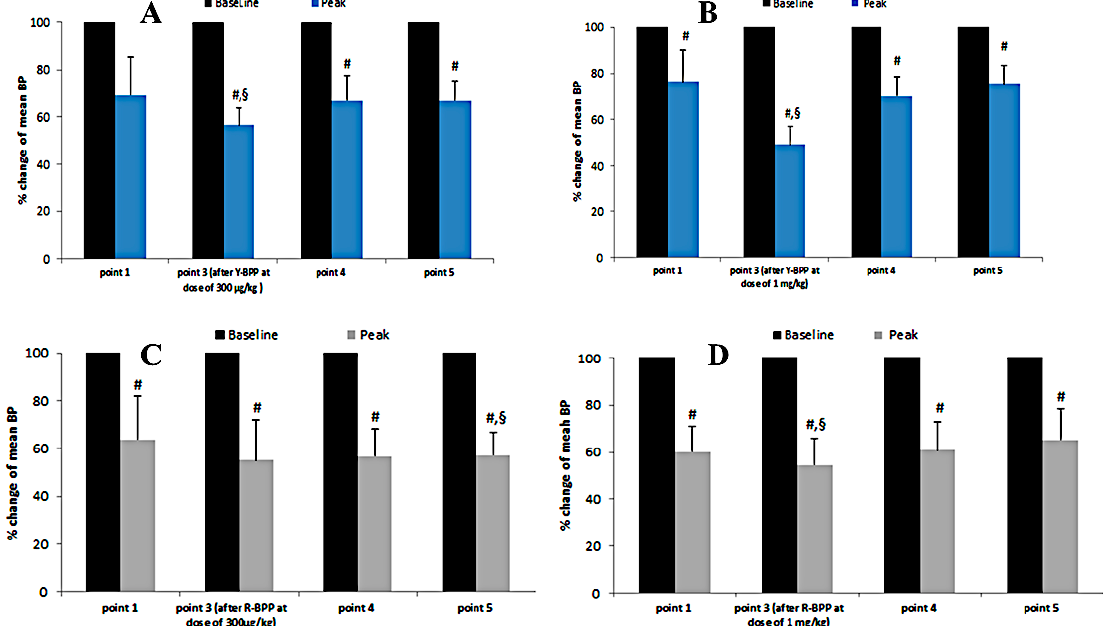
Figure 9. Percent changes from baseline for mean BPs after injections of bradykinin at a dose of 7 µg/kg in response to bradykinin-potentiating effects of A. feae peptides Y-BPP ( A , B ) and R-BPP ( C , D ) at two doses. # p ≤ 0.05 vs. baseline according to the T-Test for comparing the data of one group before and after treatment, § p ≤ 0.05 vs. point 1 according to the repeated-measures ANOVA with Dunnett post-hoc test.